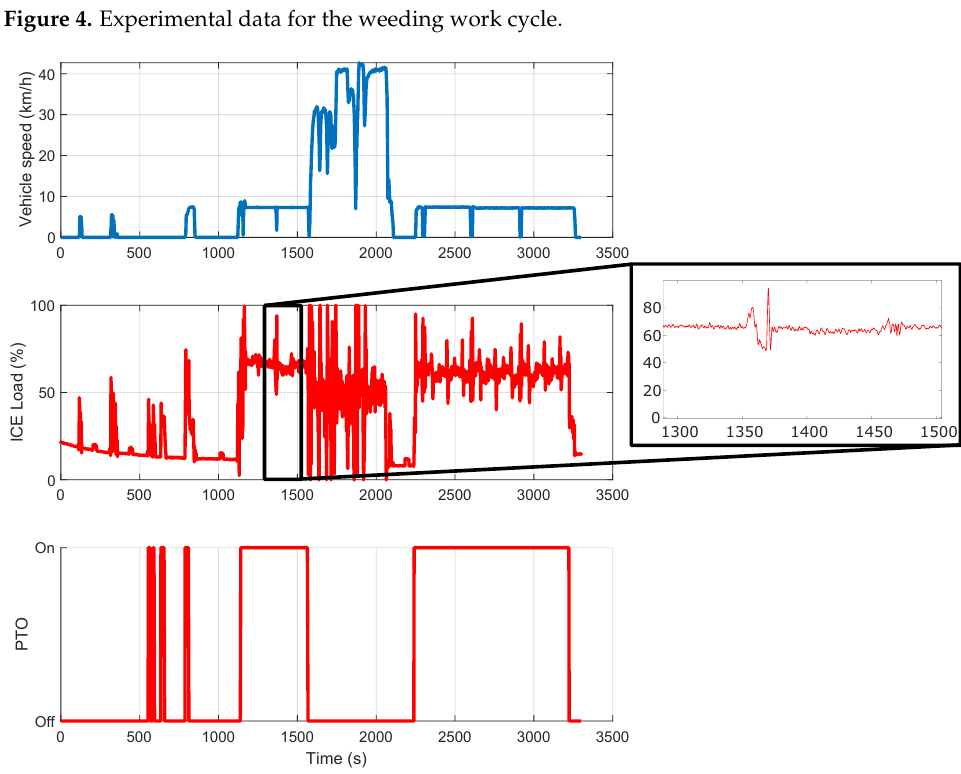
Figure 5. Experimental data for the sprayer work cycle.